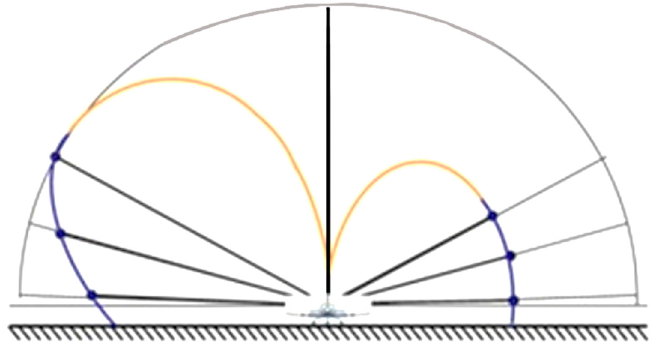
Figure 17. Section of a part of the spherical characteristic of the antenna in the vertical plane. In Figure 17, the actual measured values are marked blue (in the lower part). The angle is marked in orange (in the upper part). From the obtained diagram, it is clear that on the left side, with increasing position angle, the signal level also significantly